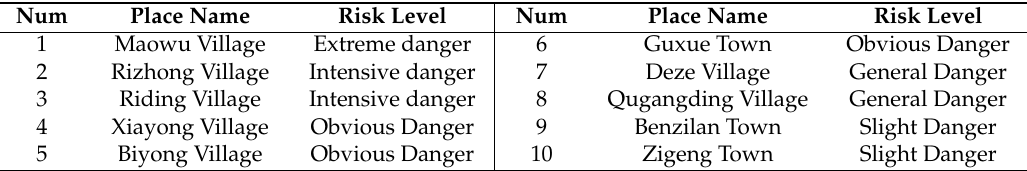
Table 10. The risk level of flood-affected areas.